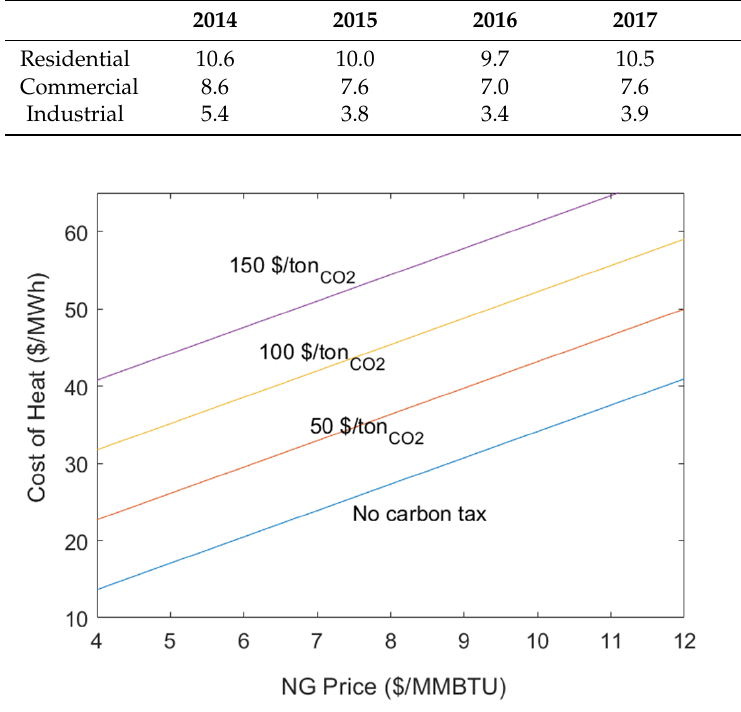
Figure 5. The cost of heat from NG as a function of NG price and carbon tax. The cost of the boiler is not included. not